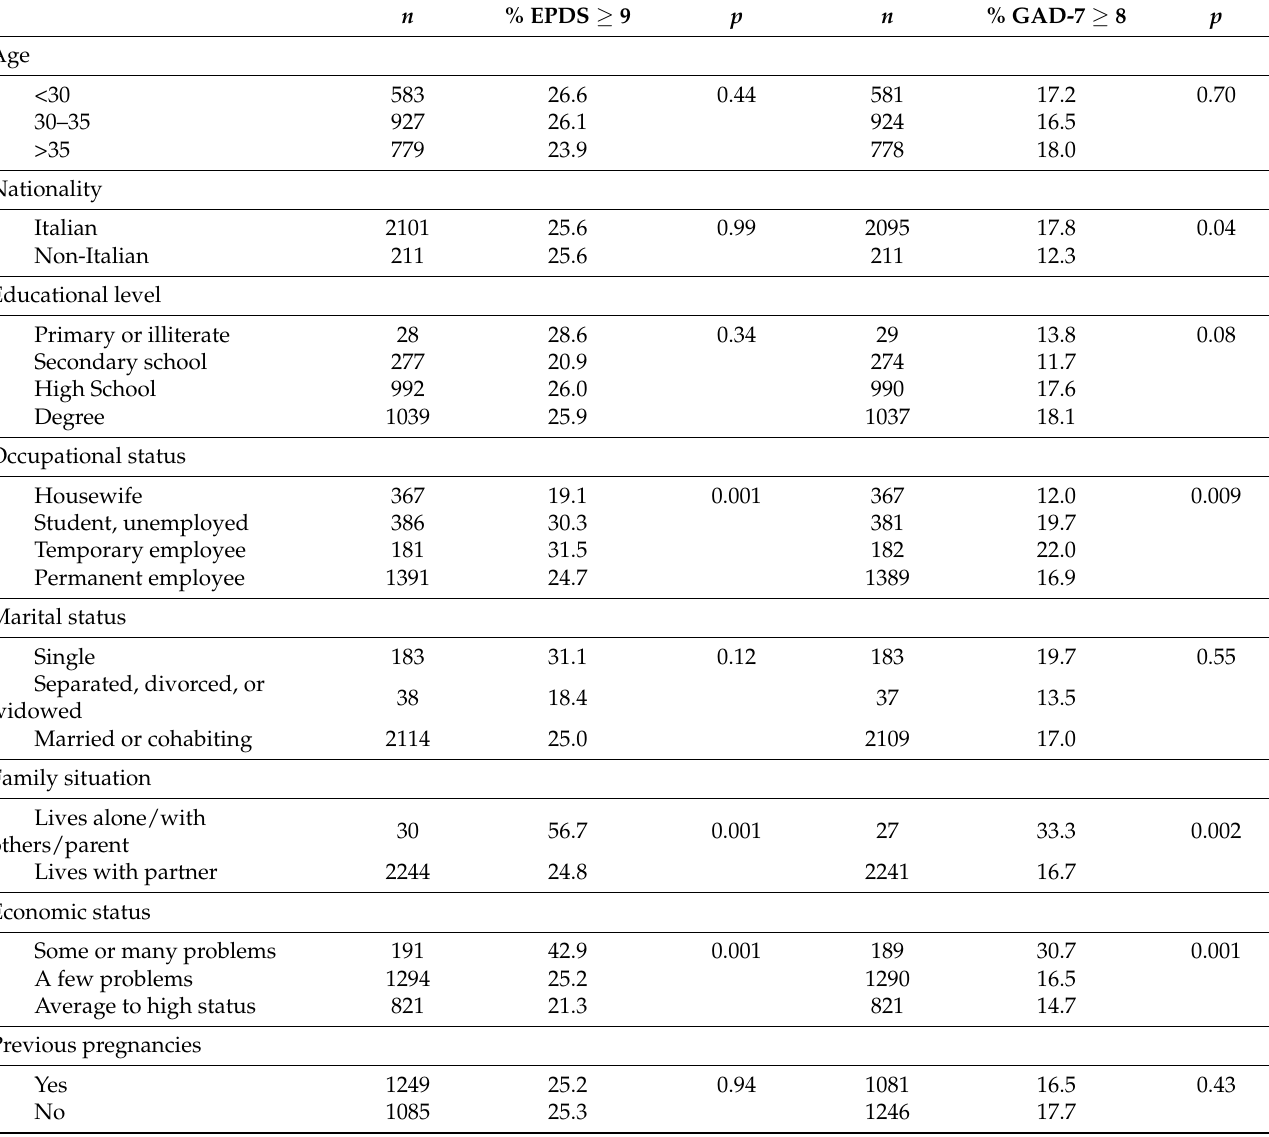
Table 3. Associations between the risk of depression and anxiety with sociodemographic variables and personal, family, and clinical